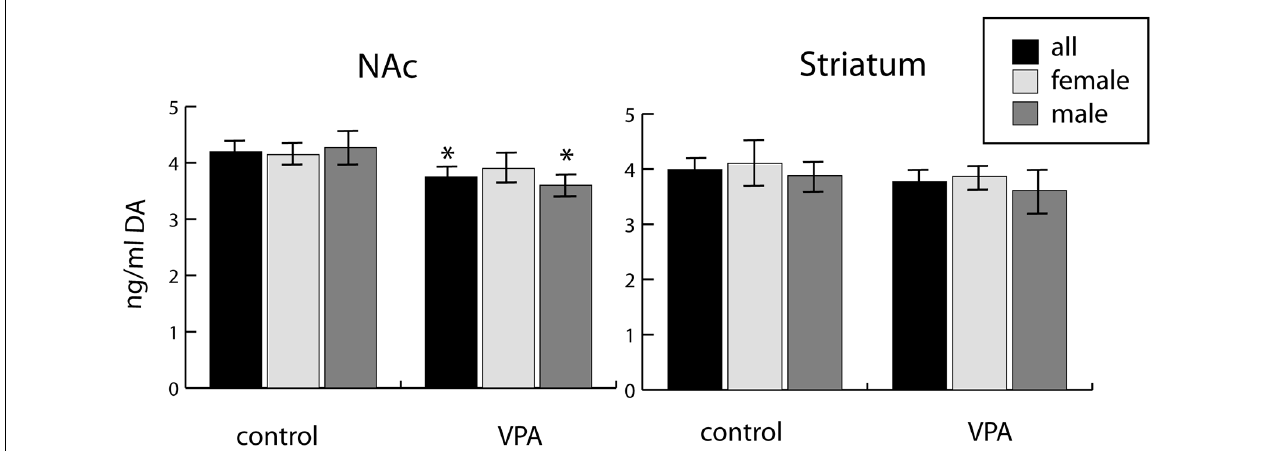
FIGURE 10 | Tissue concentrations of dopamine in two selected regions (one centered on the nucleus accumbens, NAc, and the other centered on the caudate-putamen, Striatum) freshly dissected from P7 mouse brains (10 males and 18 females), as determined by ELISA assay. The data represent the mean ± SE, n = 18 (VPA), n = 10 (control), ∗ p <